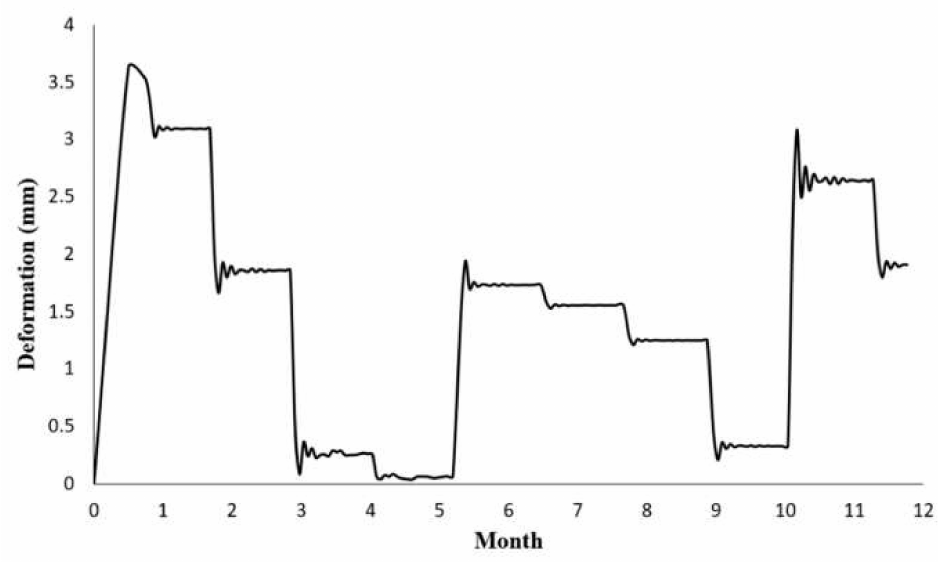
Figure 11. The history of displacement changes versus different